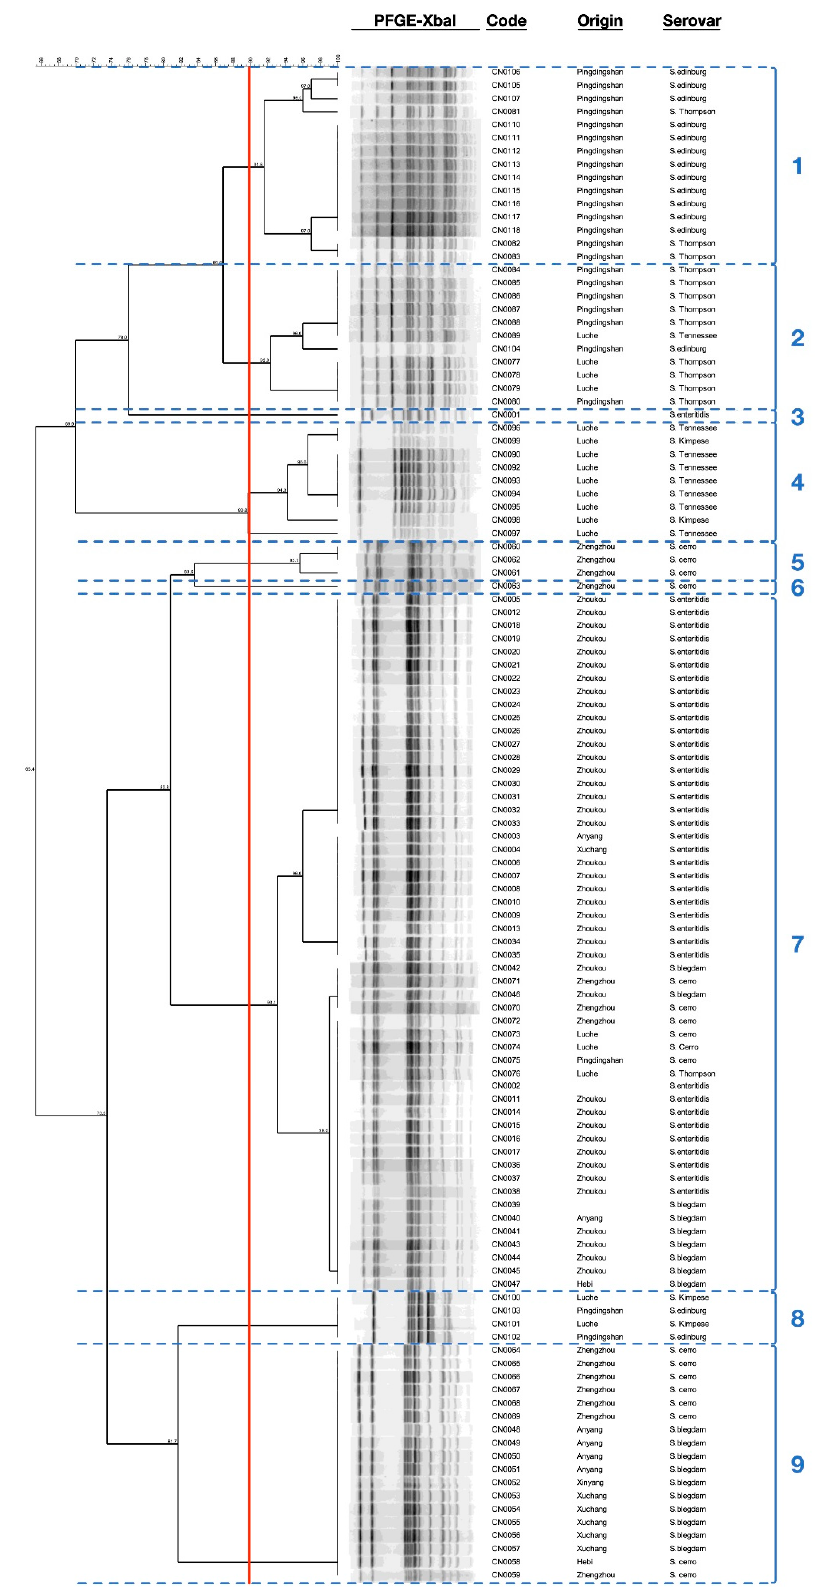
Figure 5. Dendrogram of PFGE profiles of 118 Salmonella strains. The analyzed strains were isolated from 28 hatcheries in 9 cities of Henan province, including 115 of 120 isolates, and three strains, including one S. Blegdam and two S. Enteritidis, were added for expanding